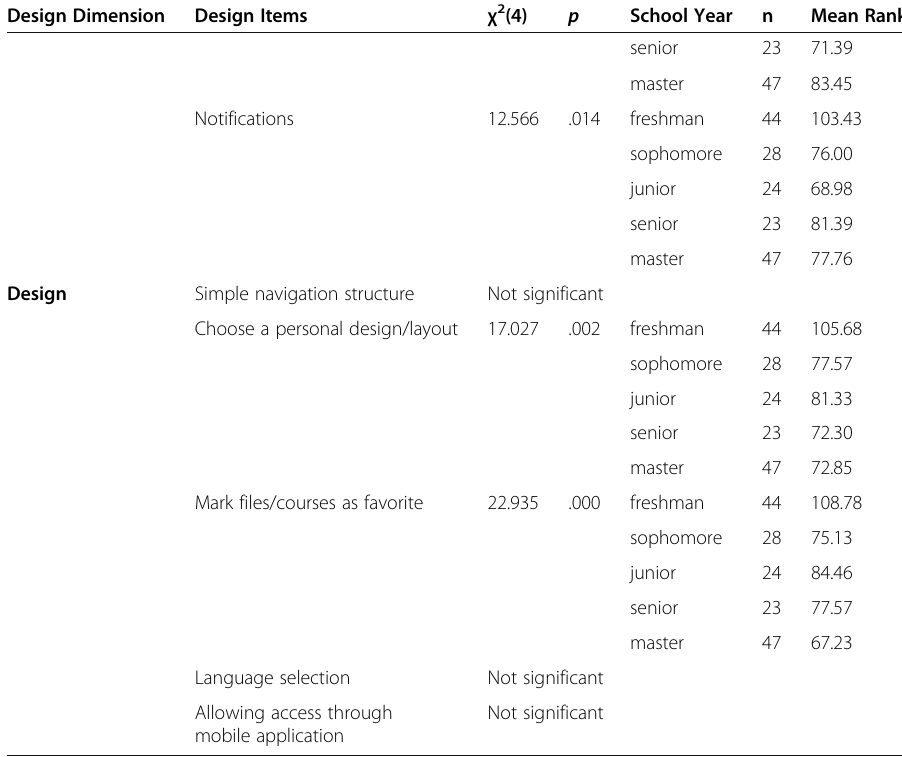
Table 6 The Kruskal Wallis H tests results for the school year variable (Continued) Design